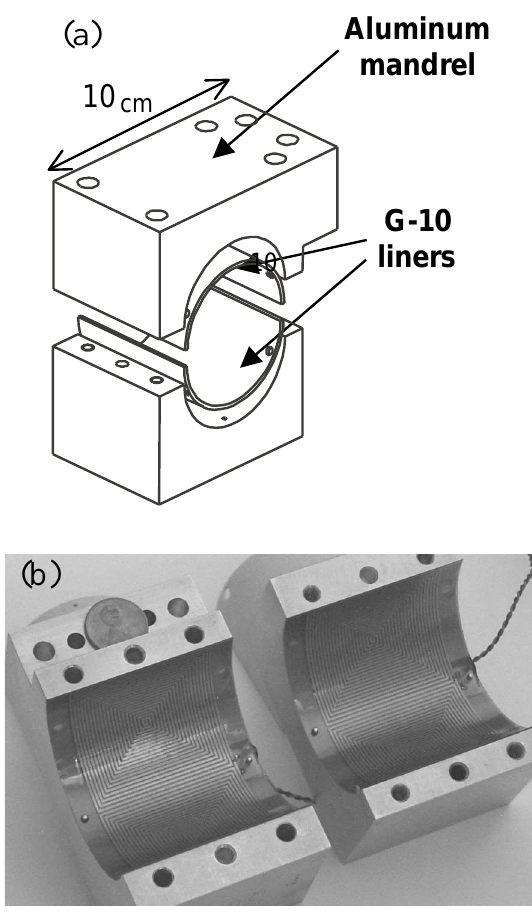
FIG. 2. (a) Exploded view of magnet assembly (the printed circuits are not shown) and (b) photograph of UMER quadrupole halves; the underside of the printed circuits can be